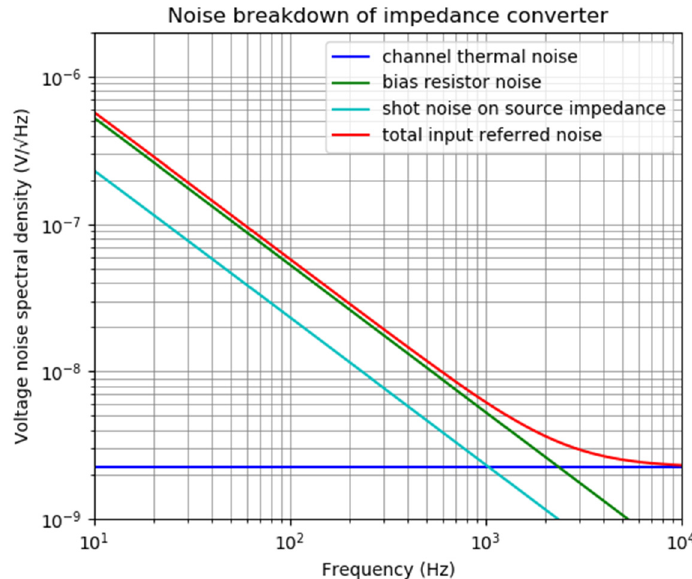
Figure 2. Noise breakdown of the impedance converter.